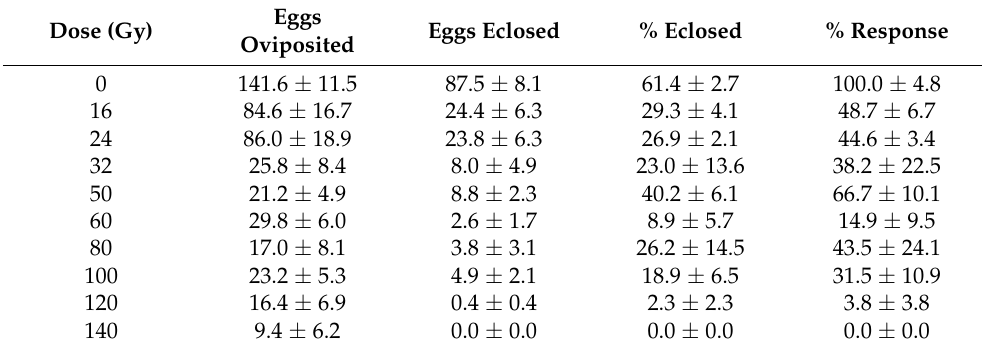
Table A2. Fecundity and fertility values (mean ± s.e.) of Bagrada hilaris in treatment 2 (FM/IF: fertile male × irradiated female) at different irradiation doses.